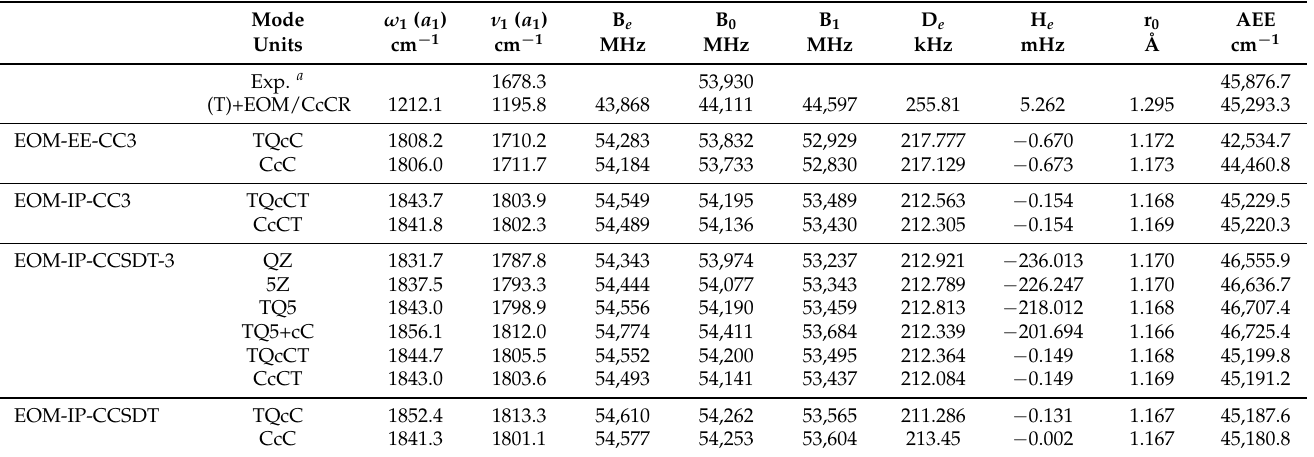
Table 3. ˜B 2 Σ + CO + Vibrational Frequencies, Distortion Constants and Geometrical